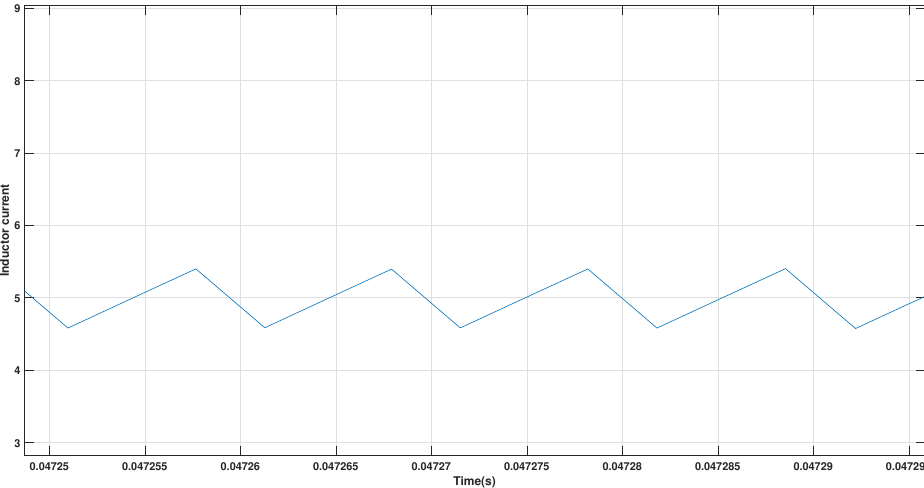
( b ) Response with r i = 0.45. Figure 5. Startup response of CI-ISE optimized Buck converter with variation of reduction factor.